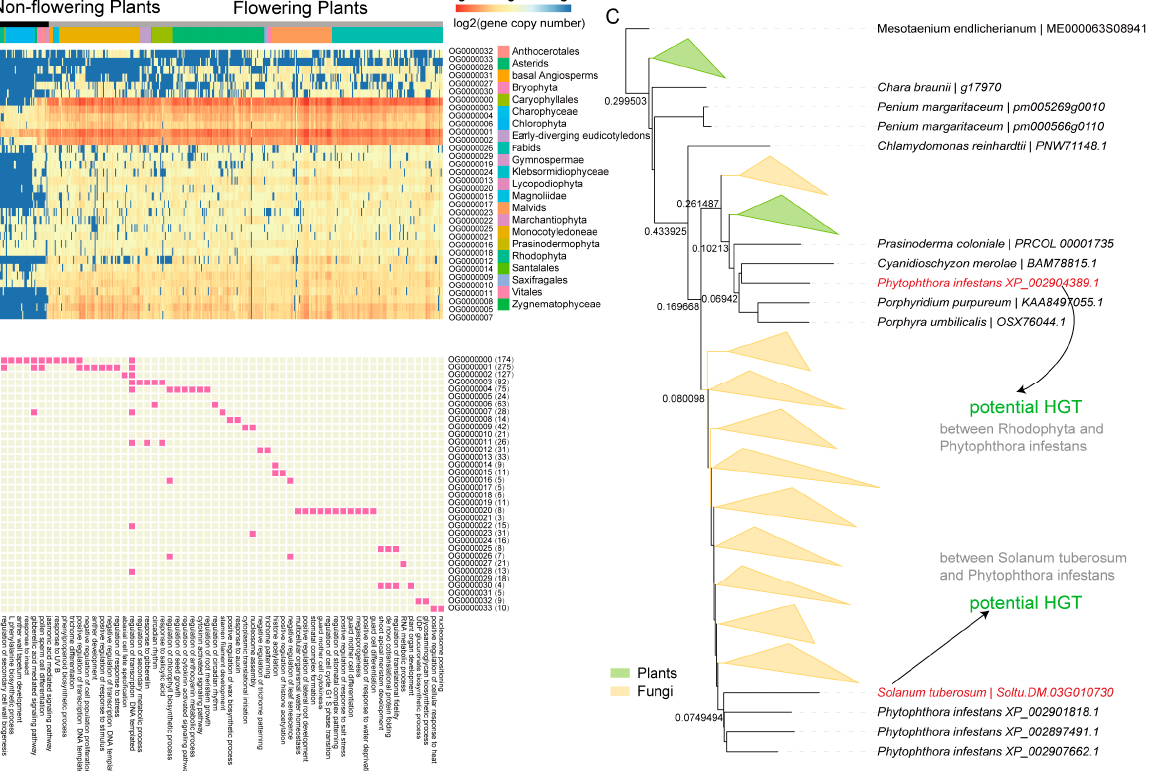
Figure 4. The copy number variation (CNV) and HGT of MYB genes. ( A ) A heatmap showing the gene copy number of 34 selected orthogroups in the 22 defined species categories. Each column represents a species, and each row represents an orthogroup. Colors for the 22 species categories were shown on the right. Flowering and non-flowering plants were labeled with dark and gray bars, respectively. Blue represents a low copy number (or absence) and red represents a high copy number. ( B ) Functional annotation of the selected 34 orthogroups. Each row shows an orthogroup and each column shows the functional description. Pink color marks the functional description of the corresponding orthogroup. ( C ) The phylogenetic tree of the orthogroup OG0000007. The tree was built using genes of OG0000007 and their close homologs in fungi. Colored shapes in the tree represent collapsed monophyletic lineages from plants (green) or fungi (yellow). Genes in red indicate those potentially derived from plant–fungi HGT. Number on the branch represented the local bootstrap value.